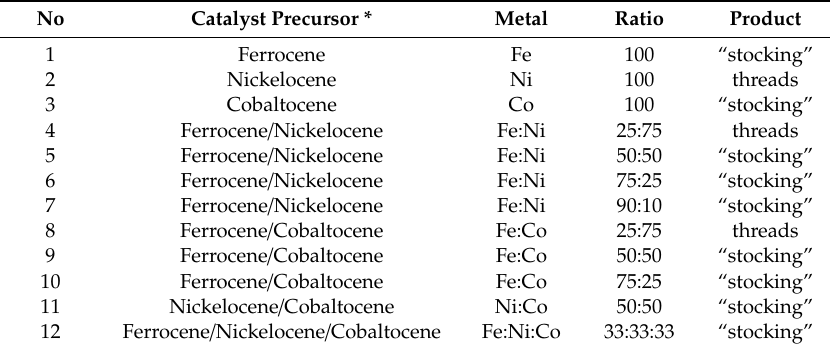
Table 2. The metallocene catalysts used in this